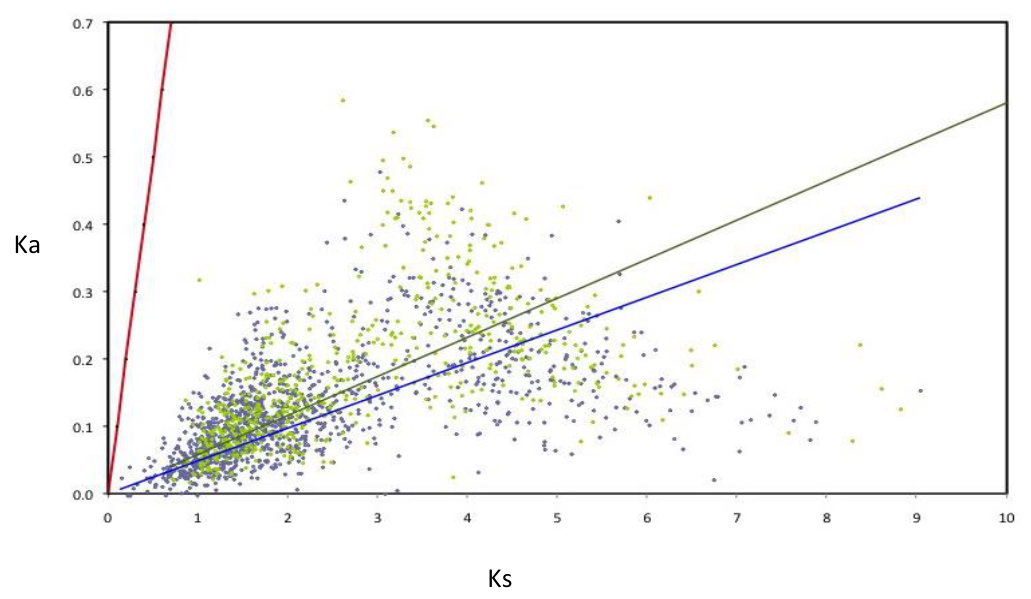
Figure 5. Rates of synonymous (Ks) and non-synonymous substitutions (Ka) in orthologous genes of Azospirillum . Linear regressions for chromosomal orthologous genes (blue line and diamonds) and non-chromosomal orthologous genes (green line and diamonds) are indicated. As neutrality (red line) assumes equal nucleotide substitution rates per synonymous and non-synonymous sites, points under the neutrality line indicate negative selection. Strong selective constraints are acting on chromosomal genes (R2 = 0.127) but are slightly less intense for non-chromosomal genes (R2 = 0.092) as can be seen by the dispersion of the green